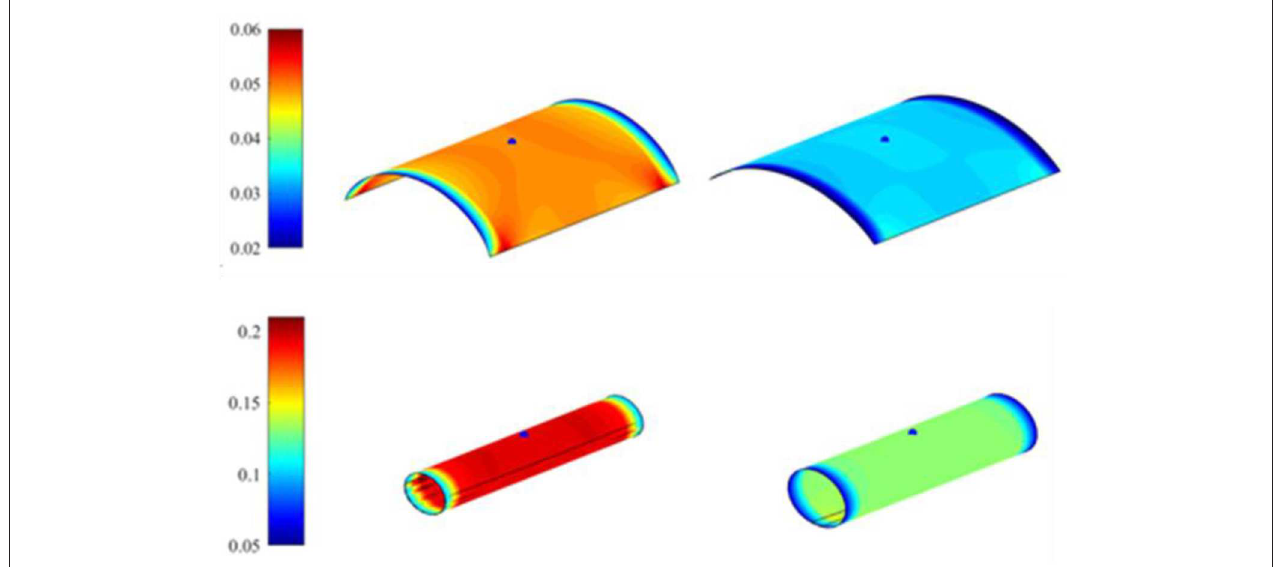
FIGURE 8 | The corresponding first principal curvature with m 2 = 0. Top: electric field 43 MV/m; bottom: electric field 86 MV/m. The figures on the left are responses with poisson’s effect and figures on the right are responses without poisson’s effect.